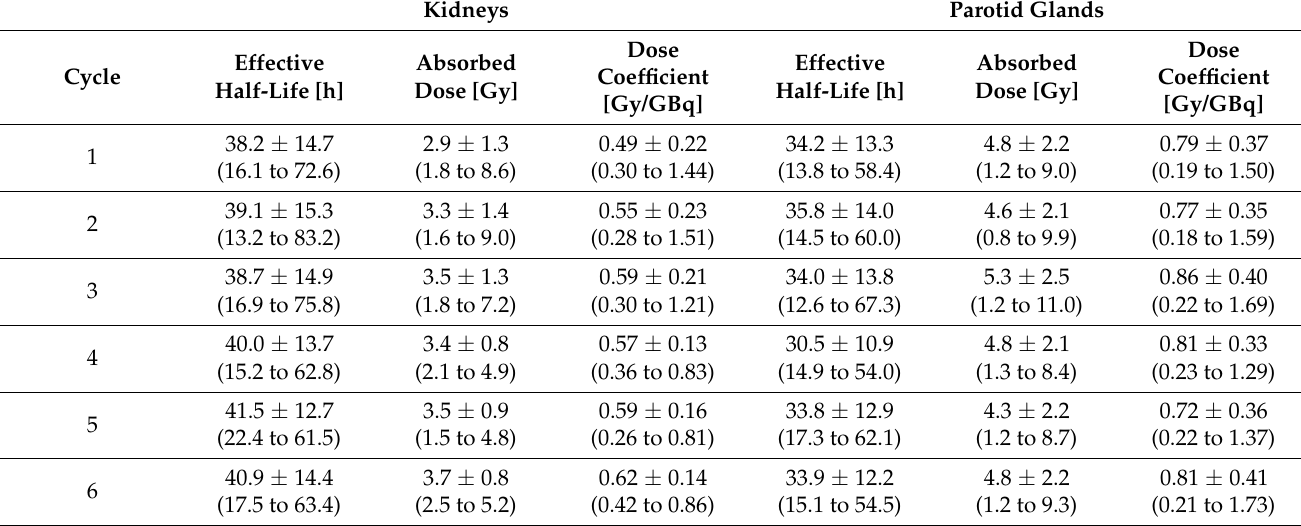
Table 3. Overview of eHL , AD s and doses rates for kidneys and parotid glands of each cycle using full dosimetry scheme (method 1). Data are given as mean ± SD (min to max). Kidneys Parotid Glands